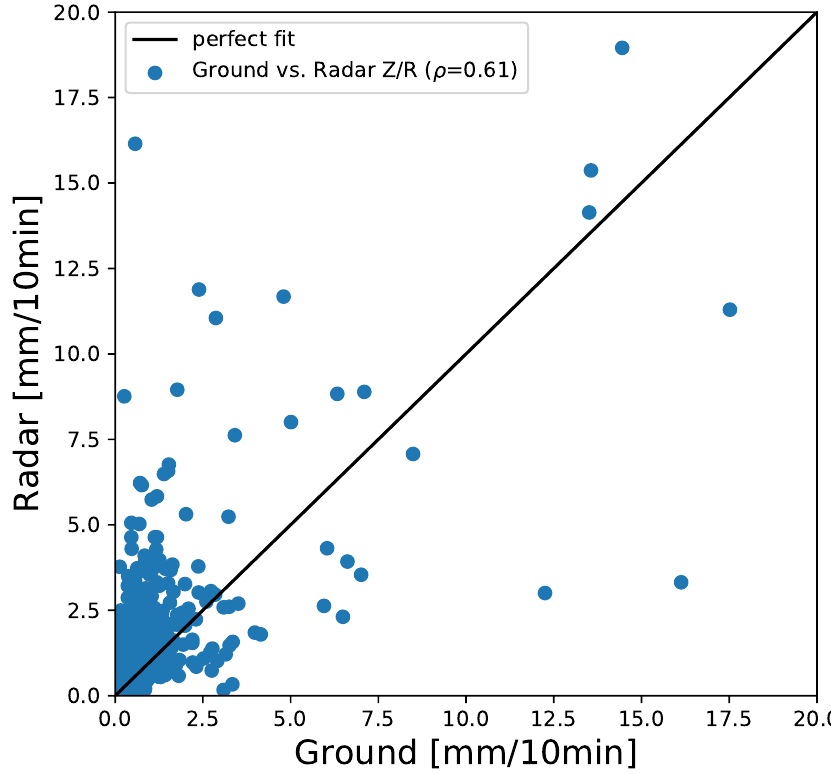
Figure 3. Scatter plot of observed precipitation and precipitation calculated from reflectivity by the Z – R relationship at location Hohenpeissenberg (Correlation coefficient ρ =